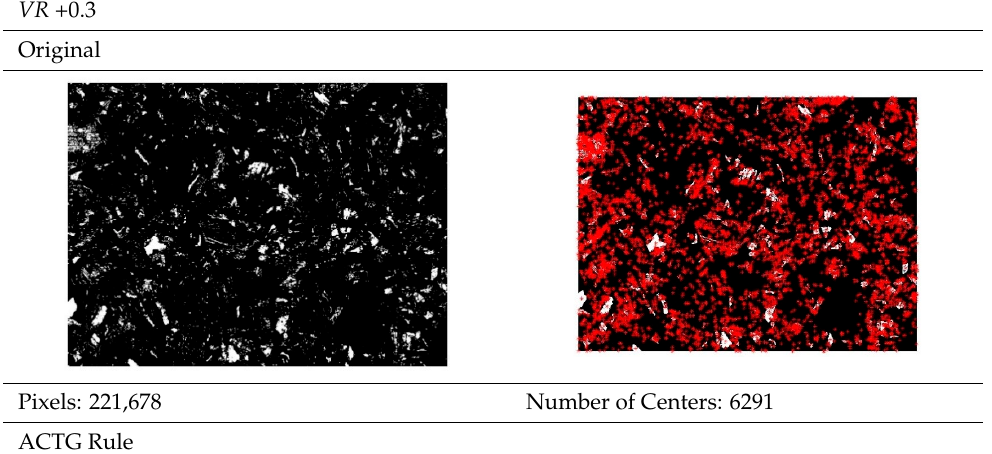
Table A1 . Images and associated pixels and number of centers corresponding to VR = +0.3.